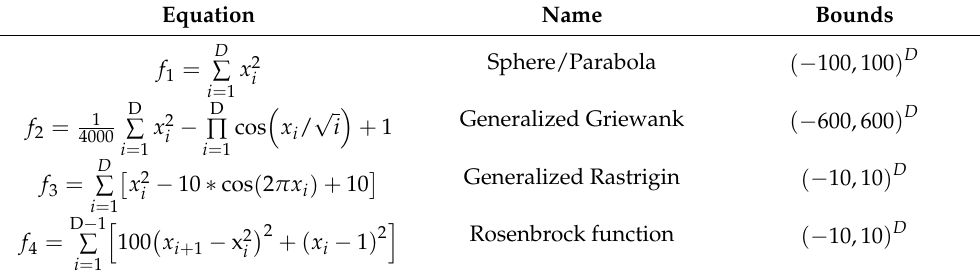
Table 1. Benchmark